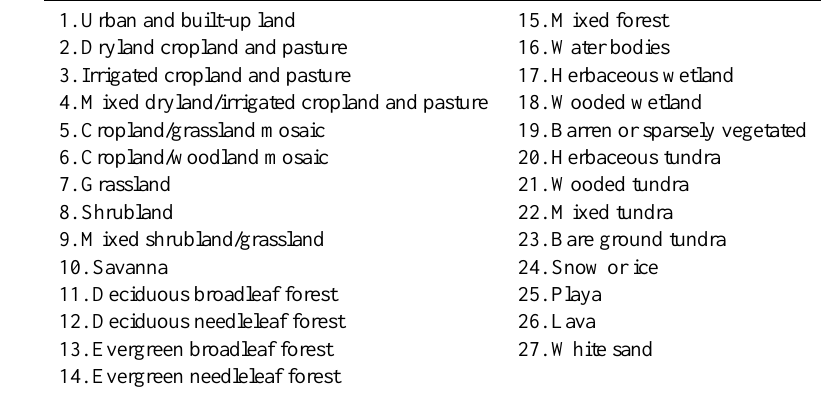
Table 1. The USGS land cover